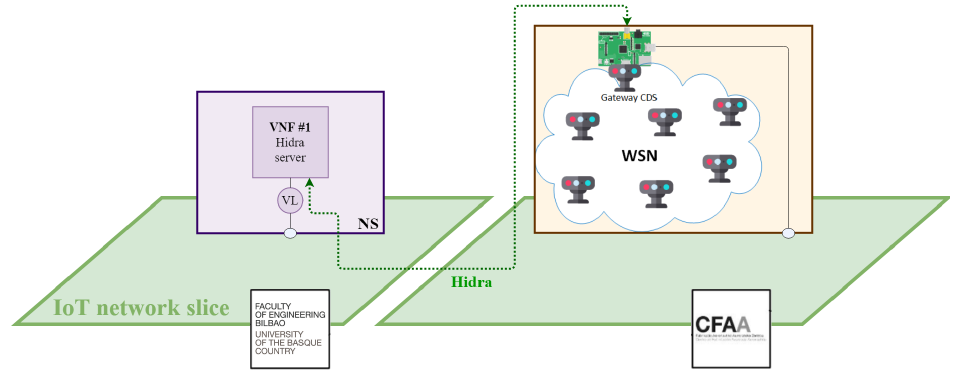
Figure 9. Industrial Internet of Things (IIoT) network